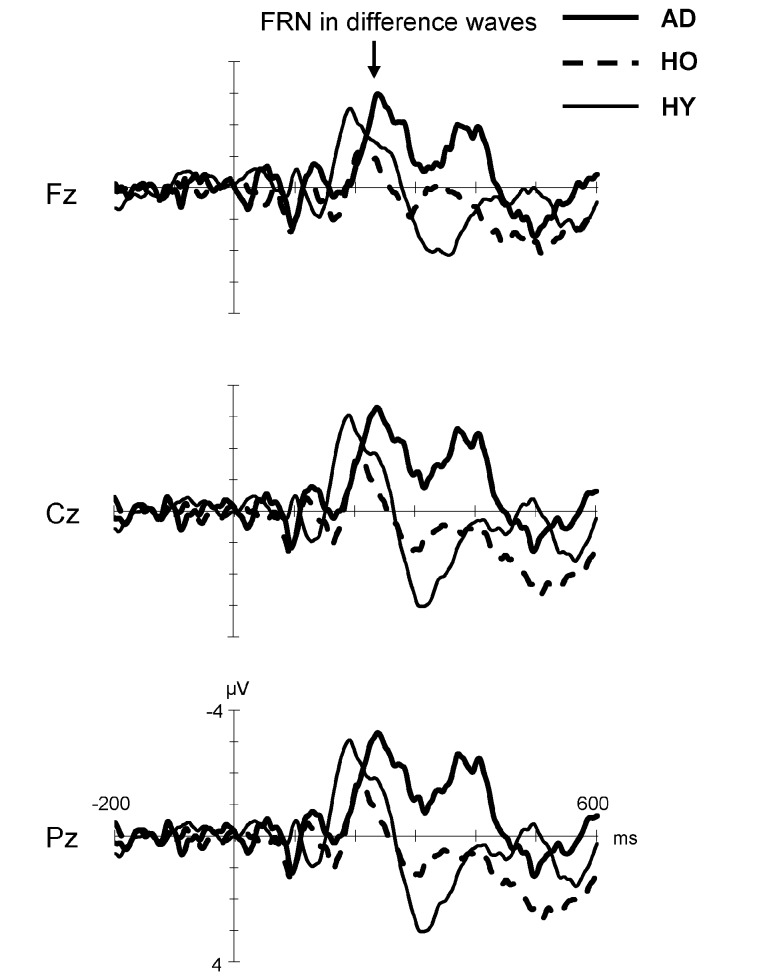
Grand-average difference waveforms created by subtracting ERP for the positive feedback from that for the negative feedback in each group. Waveforms for AD (thick solid line), HO (dashed line) and HY (thin solid line) are inserted as overlays. FRN, feedback-related negativity; AD, Alzheimer’s disease; HO, healthy old; HY, healthy young.